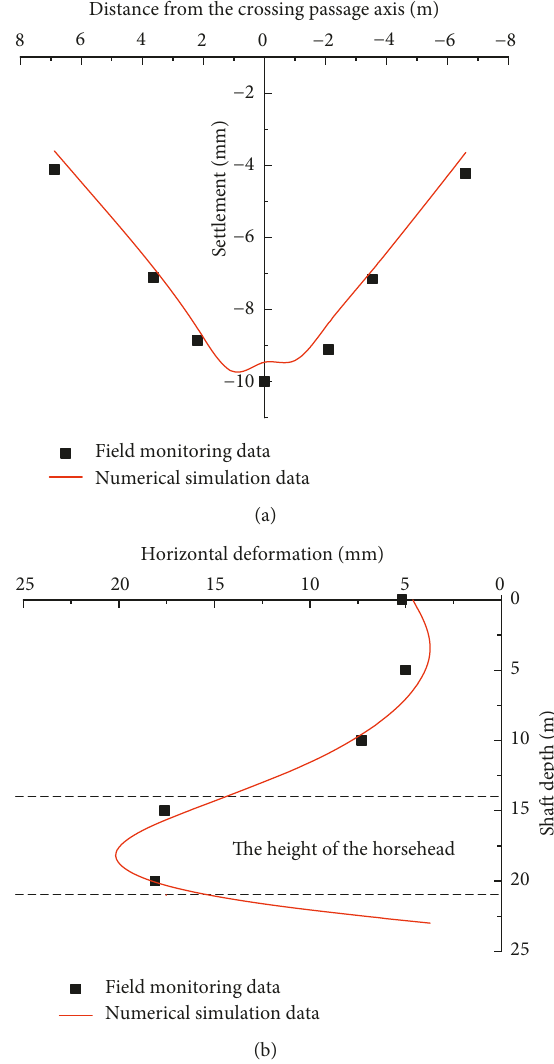
Figure 15: Comparisons of the field monitoring data and nu- merical simulation results. (a) Surface settlements. (b) Deformation of the shaft